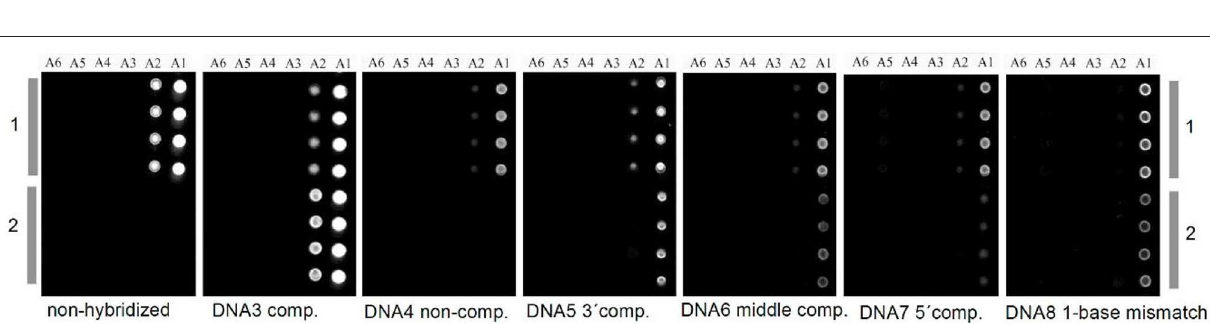
FIGURE 10 | Preparation of Immunochemical Hemoglobin Assay on the Cellulose Surface. (A) Carboxymethyl cellulose (CMC) is irreversibly adsorbed on cellulose and then antibodies are covalently conjugated on CMC-modified cellulose and (B) antibodies are pre-conjugated with CMC and then the pre-conjugated conjugate is irreversibly adsorbed on cellulose (Reproduced from Orelma et al., 2012b with permission from American Chemical Society).